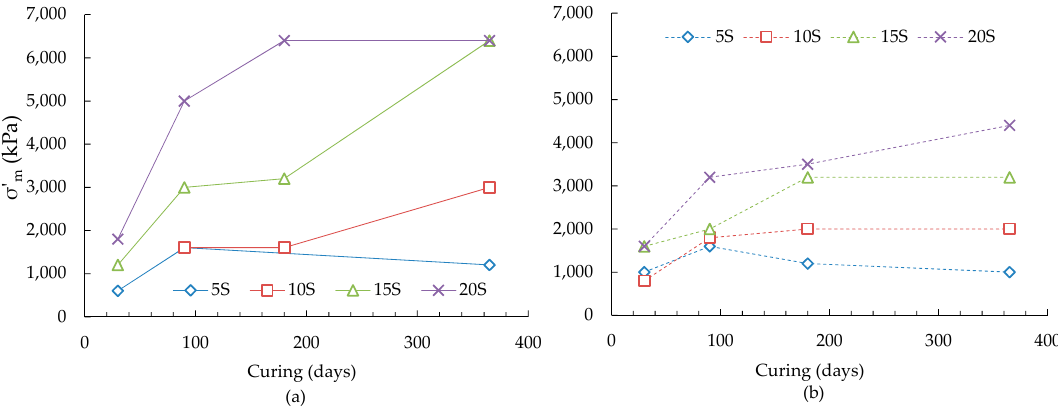
Figure 4. Maximum destructuration stresses with curing and slag contents for alkali-activated slag treated ( a ) ASS and ( b ) ASS containing 4 wt % additional pyrite.